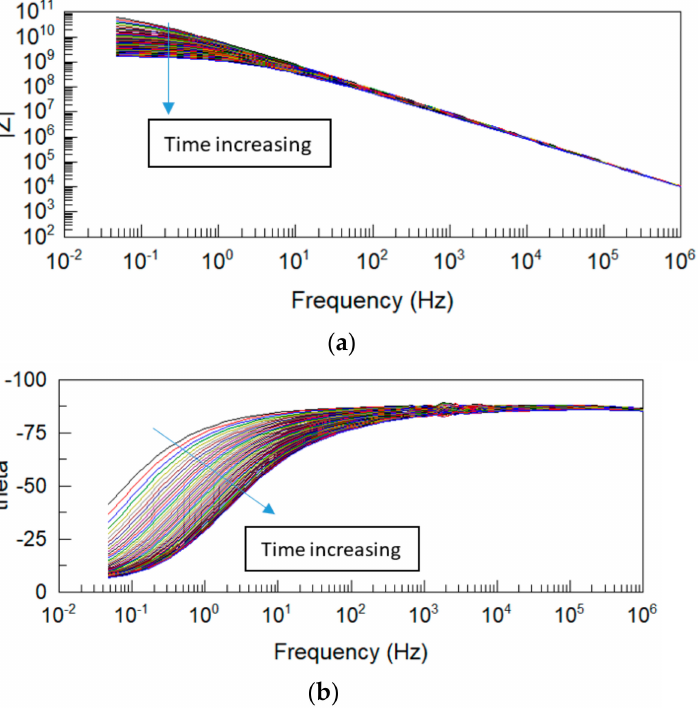
Figure 3. Typical EIS raw data obtained for panel ROX5 ( a ) impedance modulus | Z | in ohm ( Ω ) and ( b ) the phase Theta in degree ( ◦ ).